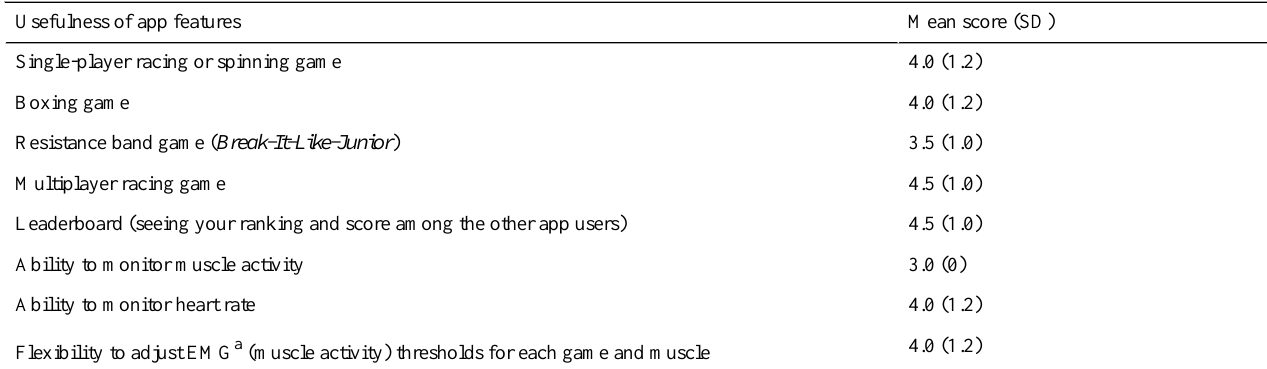
Table 7. Usefulness of various app features (both games and exercise monitoring features; ranked on a Likert scale from 1 to 5, with higher scores indicating more